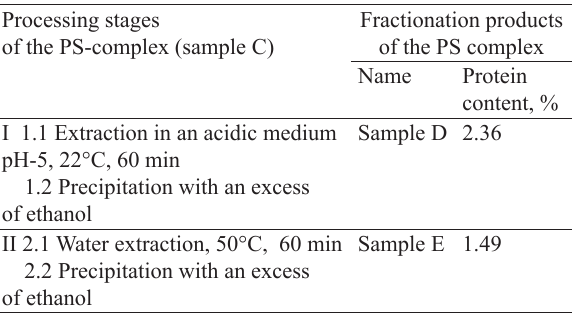
Fractionation products